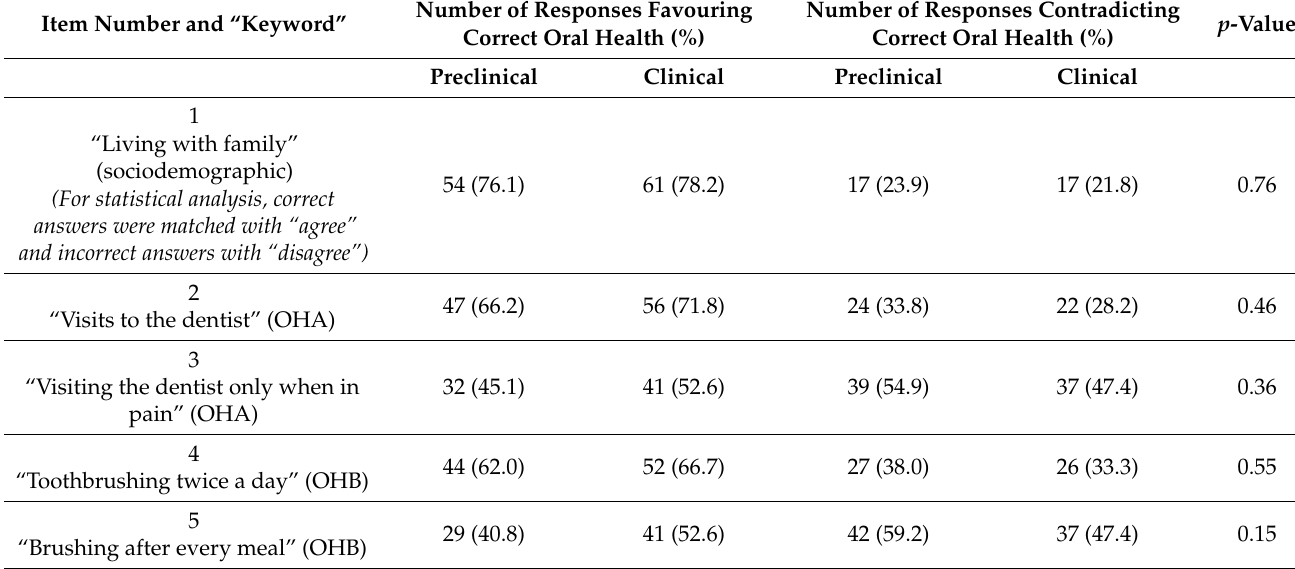
Table 4. Percentages and analysis of correct/incorrect (“agree” or “disagree”) responses to items pertaining to oral health attitudes (OHAs) and oral health behaviour (OHB) by preclinical and clinical dental